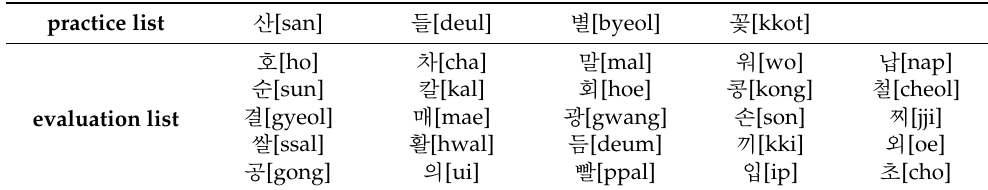
Table 8. Sample list of the speech intelligibility test for children under 10 years of age (Korean).